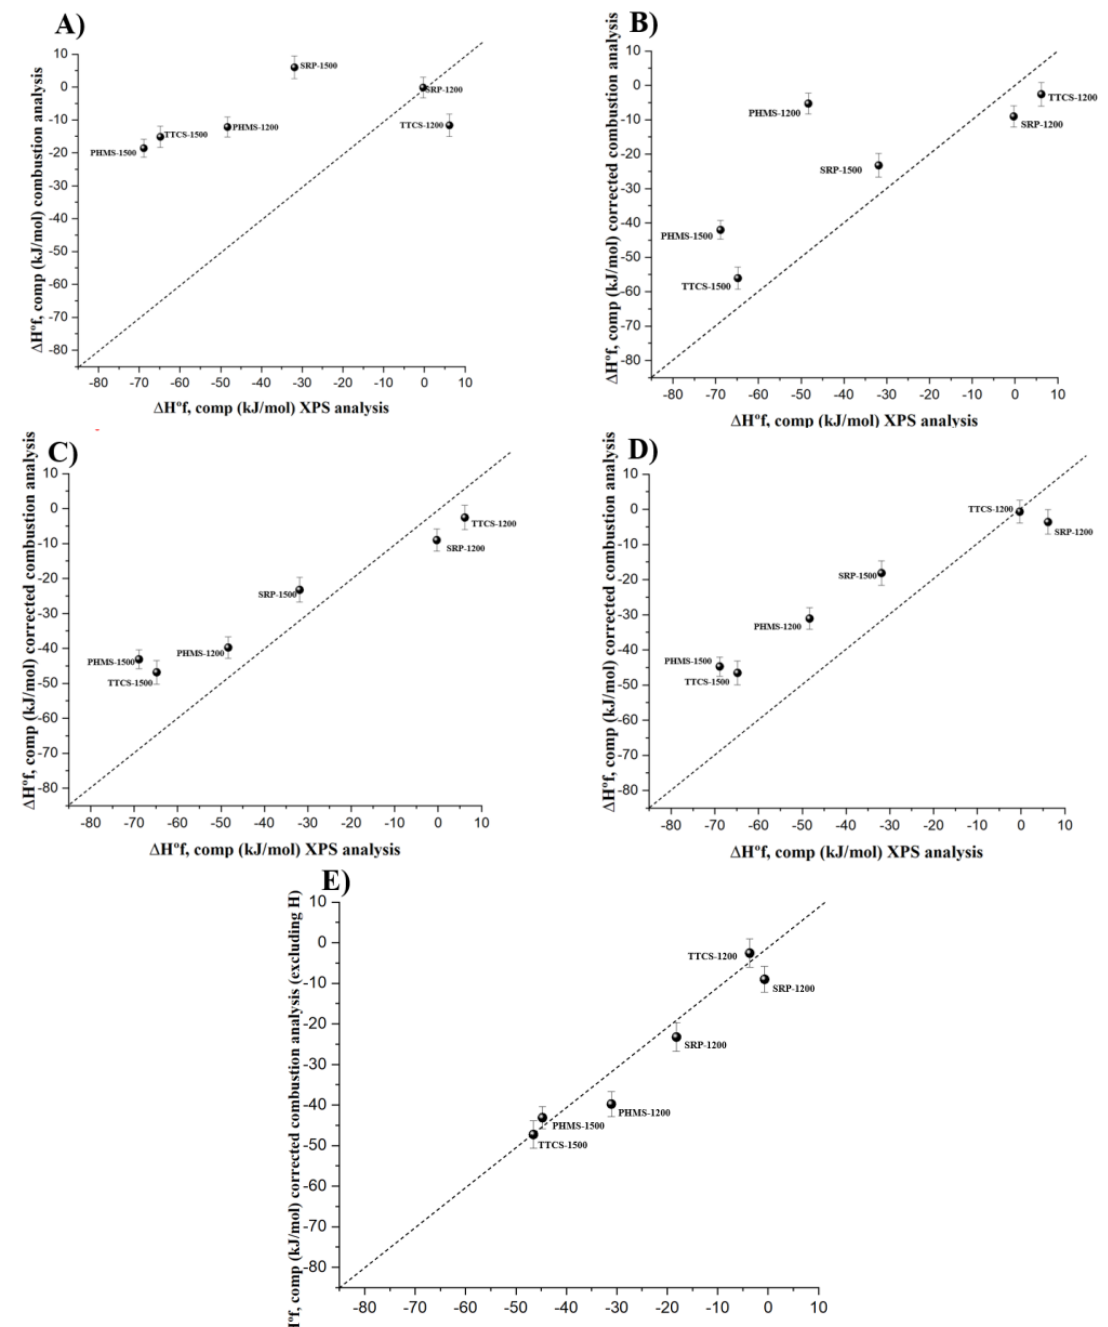
Figure 4. Comparisons of enthalpies from compositions obtained by ( A ) XPS and combustion analysis (including hydrogen), ( B ) XPS and Si-corrected combustion analysis (excluding hydrogen), ( C ) XPS and combustion analysis (excluding hydrogen) corrected for Si, plus O and C as average of value detected by XPS and combustion technique, ( D ) XPS and combustion analysis (including hydrogen) corrected for Si, plus O and C as average of value detected by XPS and combustion technique, and ( E ) enthalpy of formation calculated from corrected combustion analysis including hydrogen ( x -axis) versus excluding hydrogen ( y -axis). The 1:1 dashed line corresponds to perfect